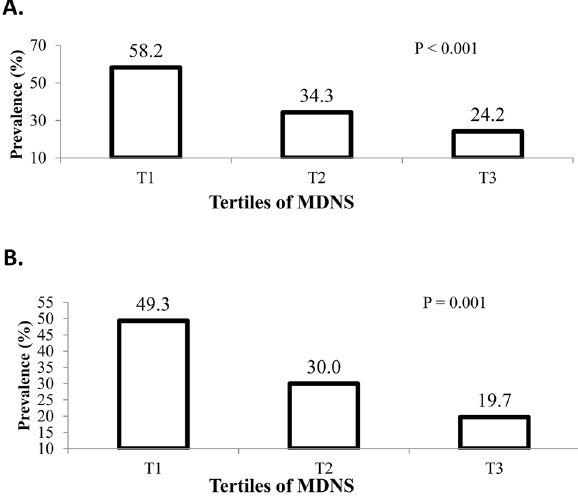
Figure 1. Prevalence of MUO across tertiles of MDNS in the study population. ( A ) MUO based on IDF definition. ( B ) MUO based on IDF/HOMA-IR